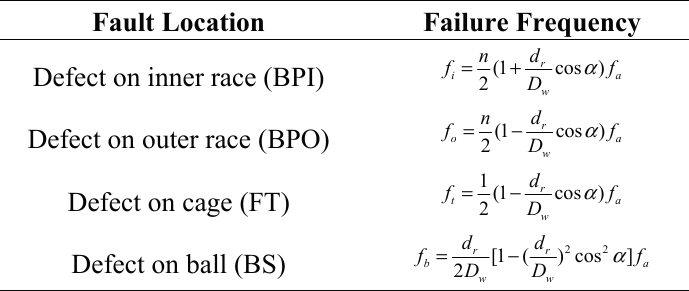
Table 3. Bearing characteristic